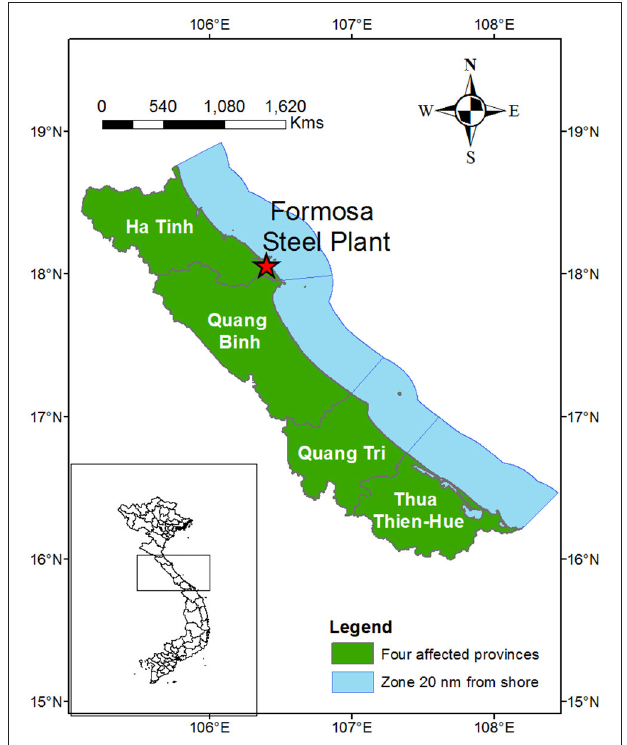
FIGURE 1 | Closure areas associated with the 2016 fish kill event in Vietnam.